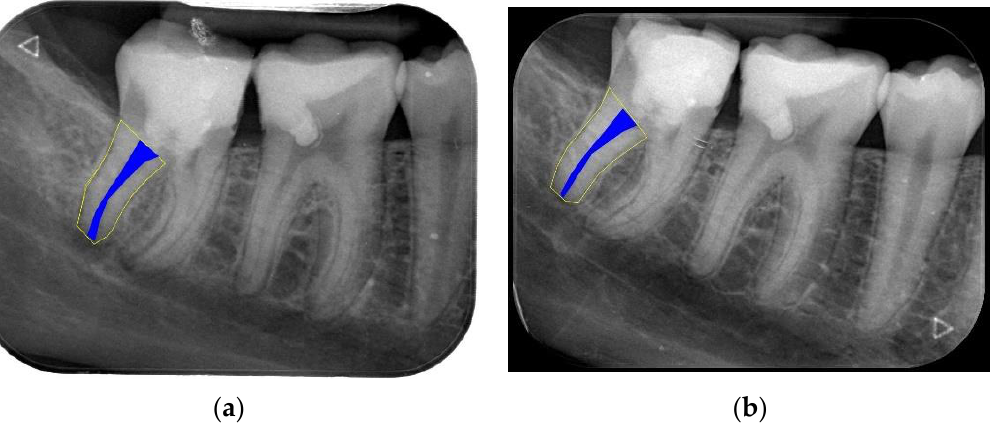
Figure 1. Measurement of RRA in an anterior tooth ( a ) at the end of REP, ( b ) at the 12-month follow-up. Uncertain healing and an unchanged apical closure are observed.